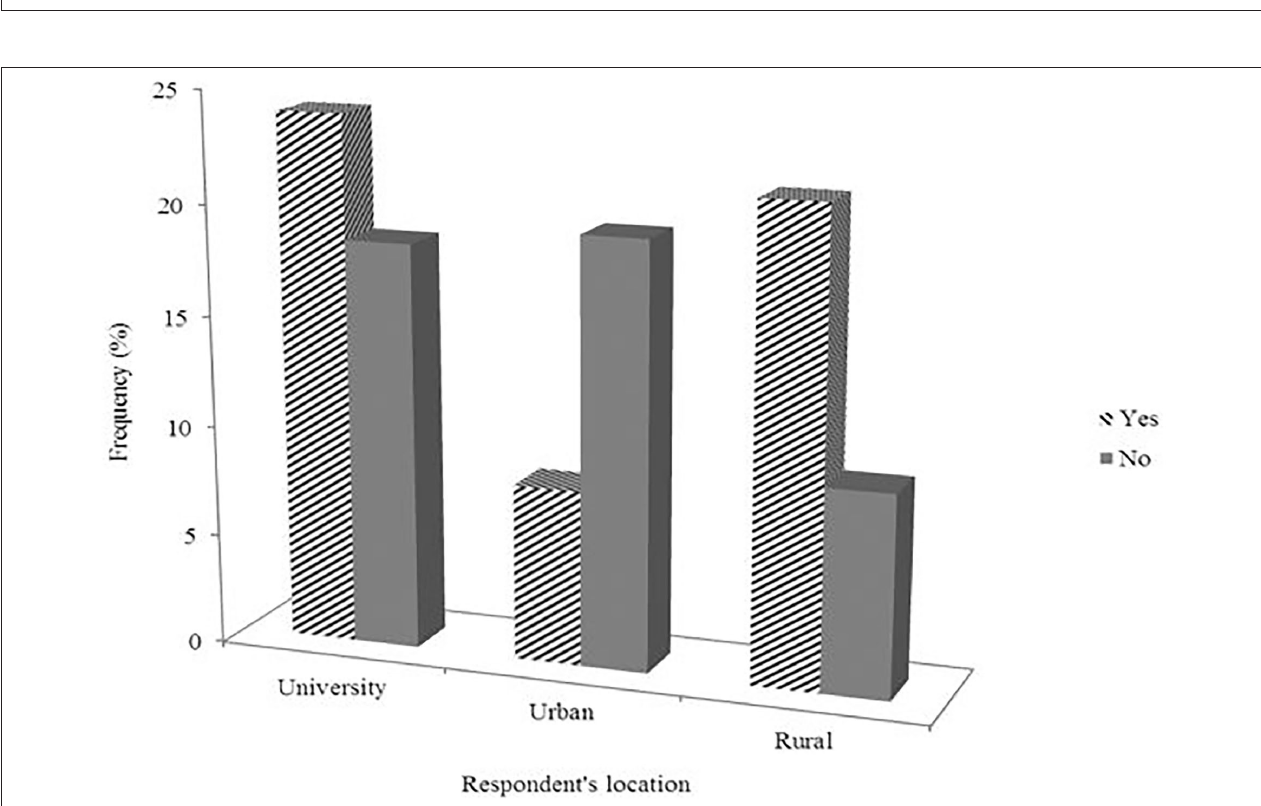
FIGURE 4 | Effect of location on consumer’s interest in the consumption of cultured beef.